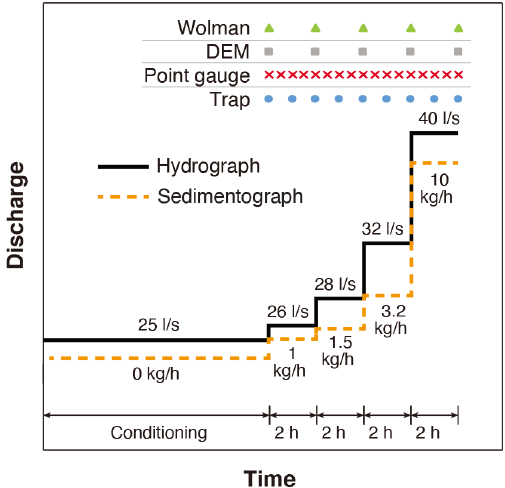
Figure 1. Water and sediment supply implemented in the experi- ments. Markers at the top of the figure denote the time of measure- ments during the hydrograph phase. The time of the measurements during the conditioning phase is not shown in this